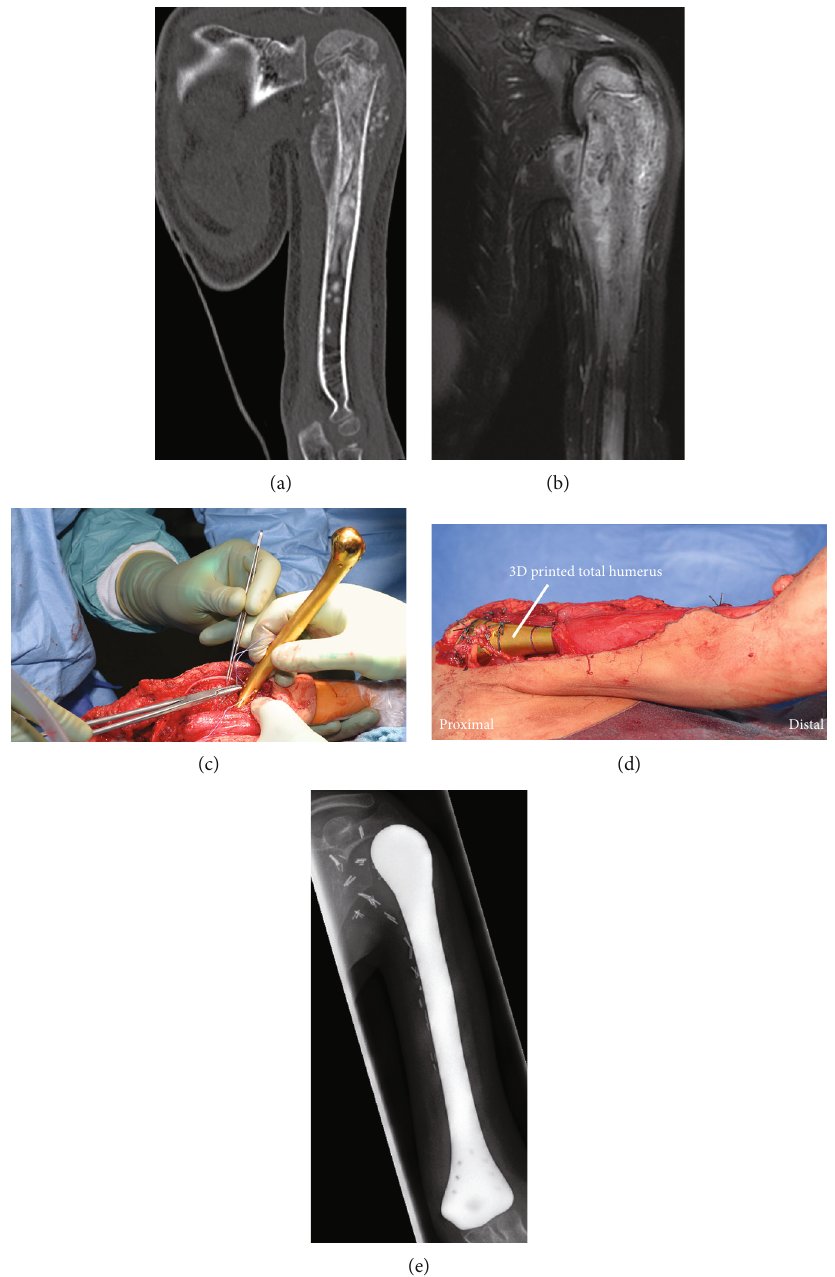
Figure 1: A fi ve-year-old girl with a high-grade osteosarcoma of the left proximal humerus. (a, b) CT and MRI scans showed a locally advanced tumor involving almost the complete humerus. (c, d) Reconstruction of the osseous defect by the 3D printed total humerus. (e) X-ray image one year after surgery showed no